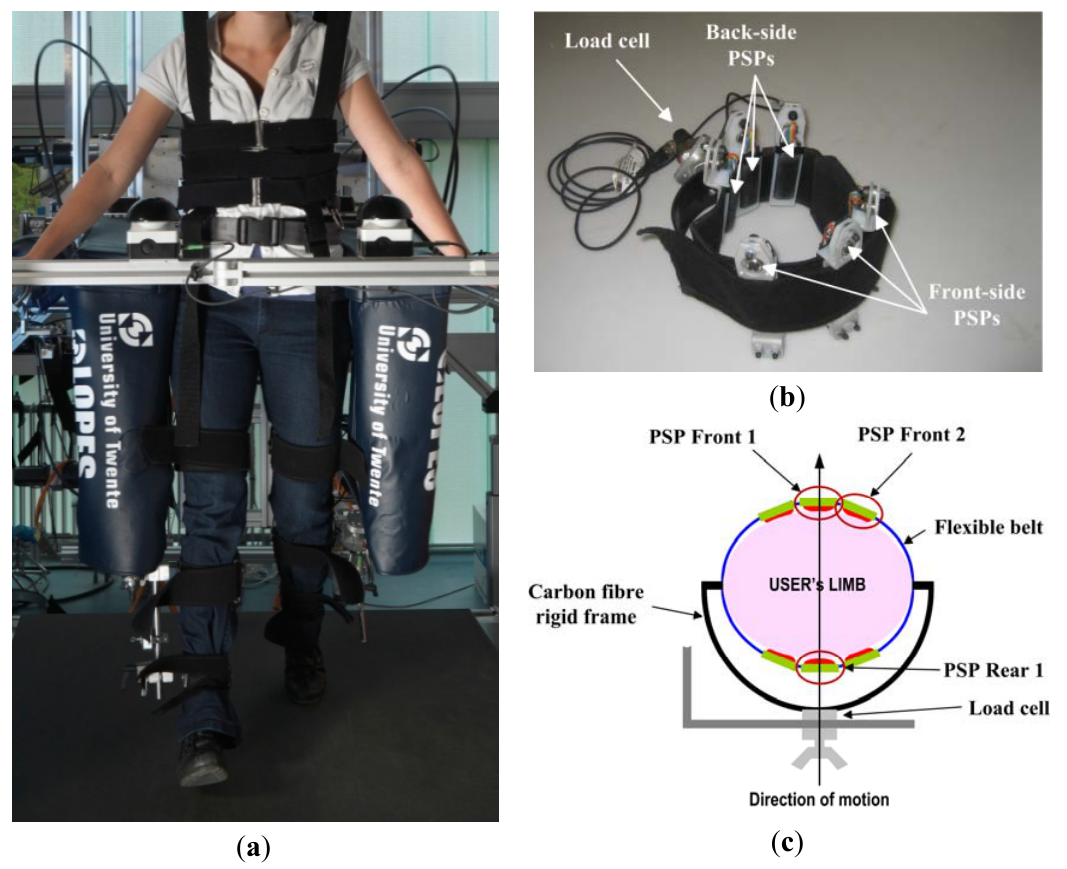
Figure 12. ( a ) Overview of the LOPES exoskeleton; ( b ) right-leg thigh cuff sensorized with six PSPs 1.1; ( c ) schematic view of the right-leg sensorized cuff (adapted from